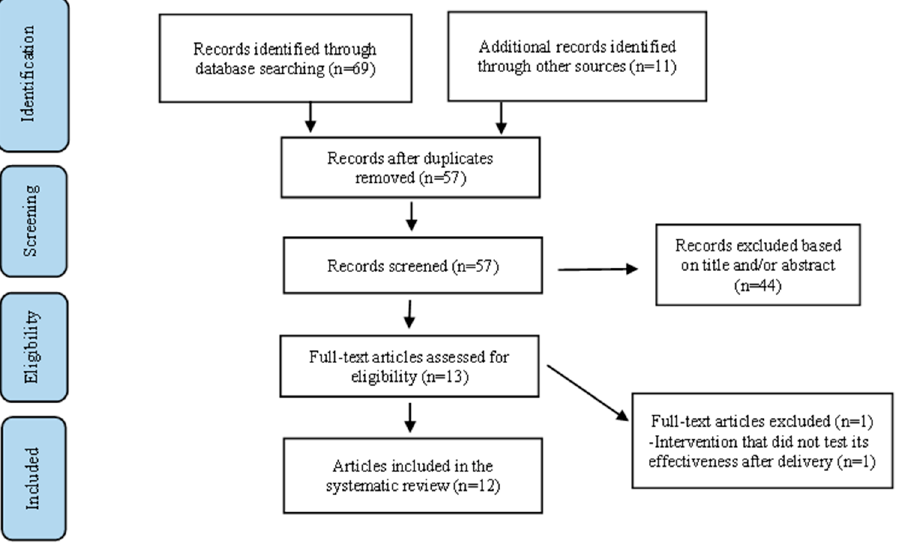
Figure 1. Study Selection Flow Diagram .